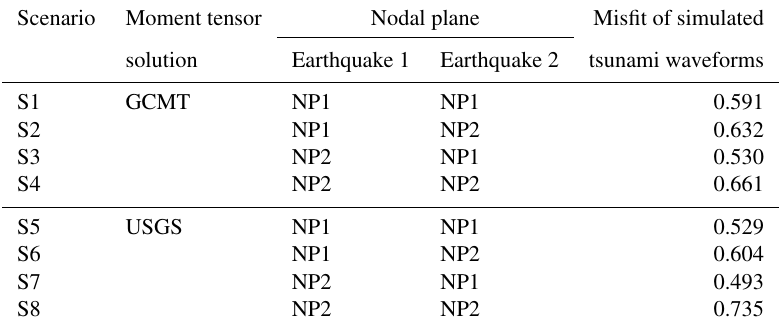
Table 7. Validation of the simulated tsunami waveforms using single fault models with eight different models of focal mechanisms estimated by GCMT and